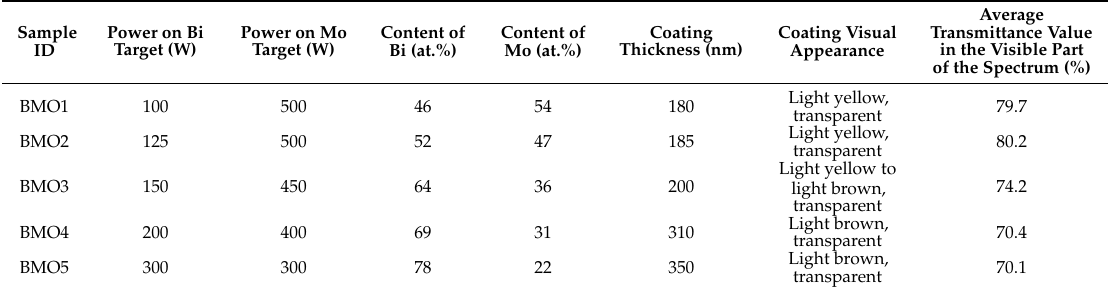
Table 1. Compositional properties and thickness of bismuth molybdate